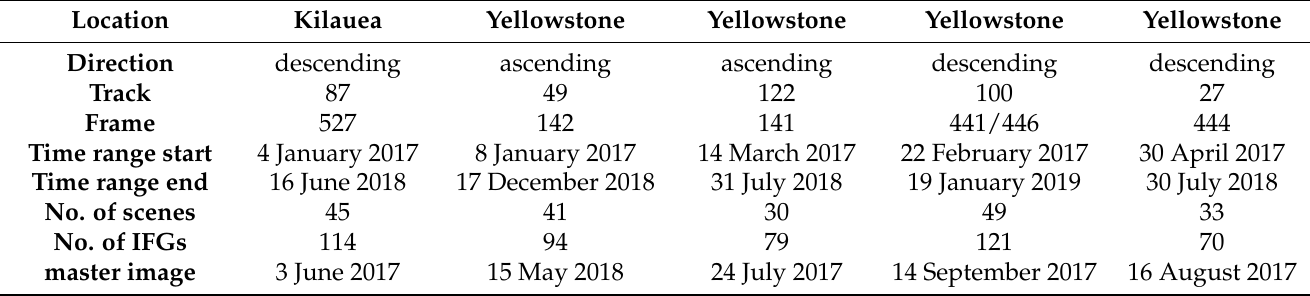
Table 1. Details of the Sentinel-1 DInSAR data presented in this